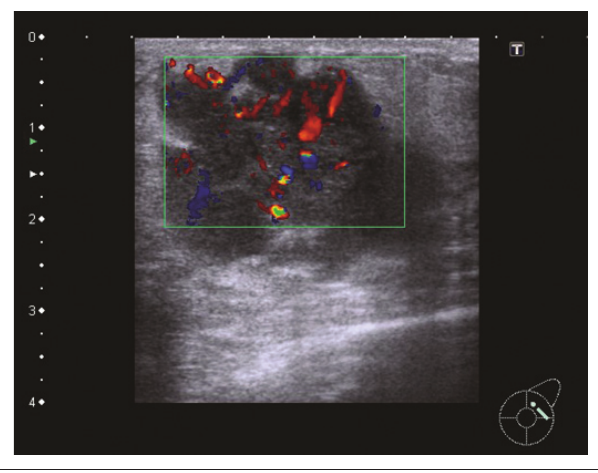
FIGURE 2: Ultrasound image of the hypoechoic mass in the left breast demonstrating posterior enhancement and increased